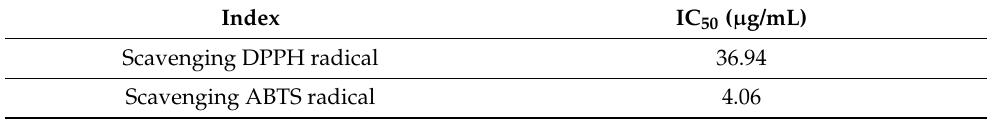
Table 3. The IC 50 value was defined as the concentration of G. oxydans FBFS97